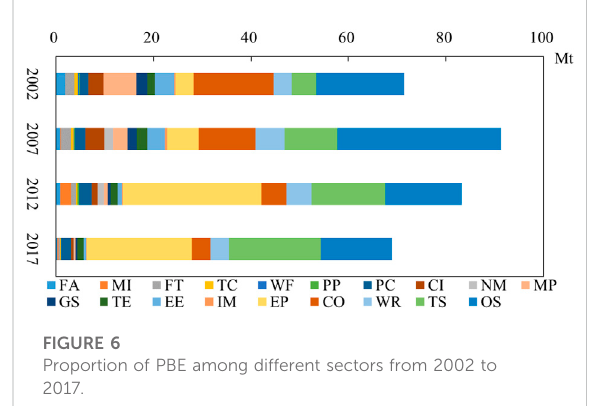
FIGURE 6 Proportion of PBE among different sectors from 2002 to 2017.